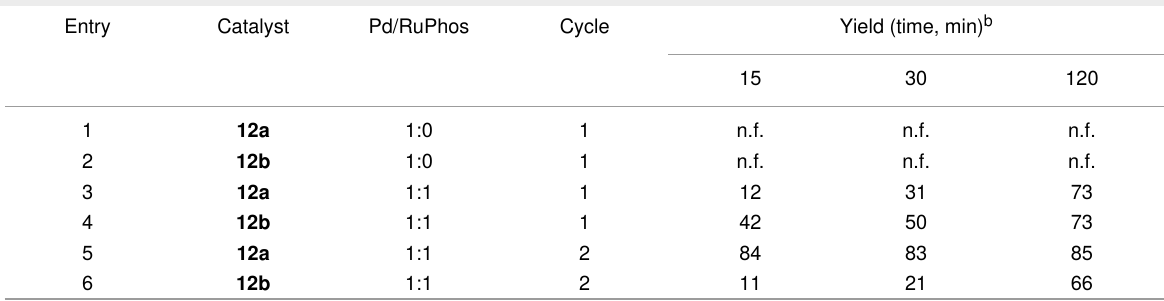
Table 2: Negishi reaction between 5 and 6 catalyzed by 12a , b . a